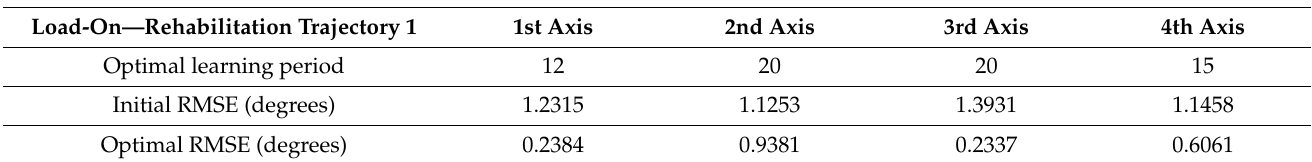
Table 10. Trajectory 1 — before and after applying ILC — table comparing the tracking results of each axis with and without loading effect.